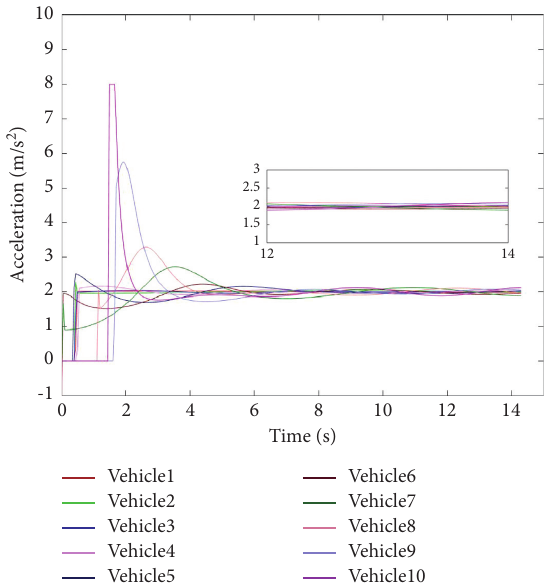
Figure 10: Acceleration history under proposed controller